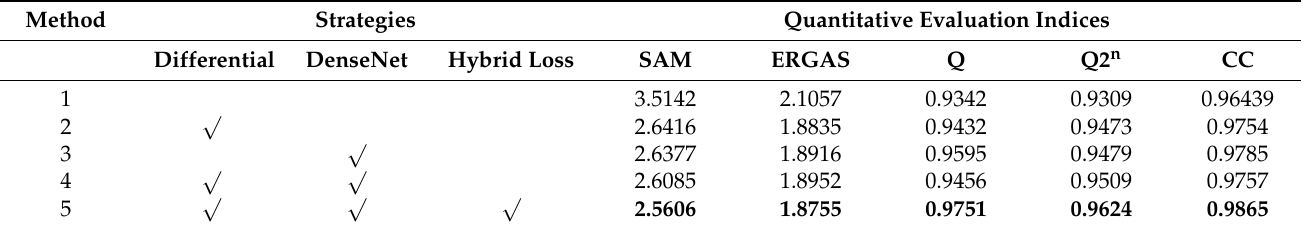
Table 3. Quantitative evaluation results of ablation experiments on the WorldView-2 dataset. The values in bold represent the best